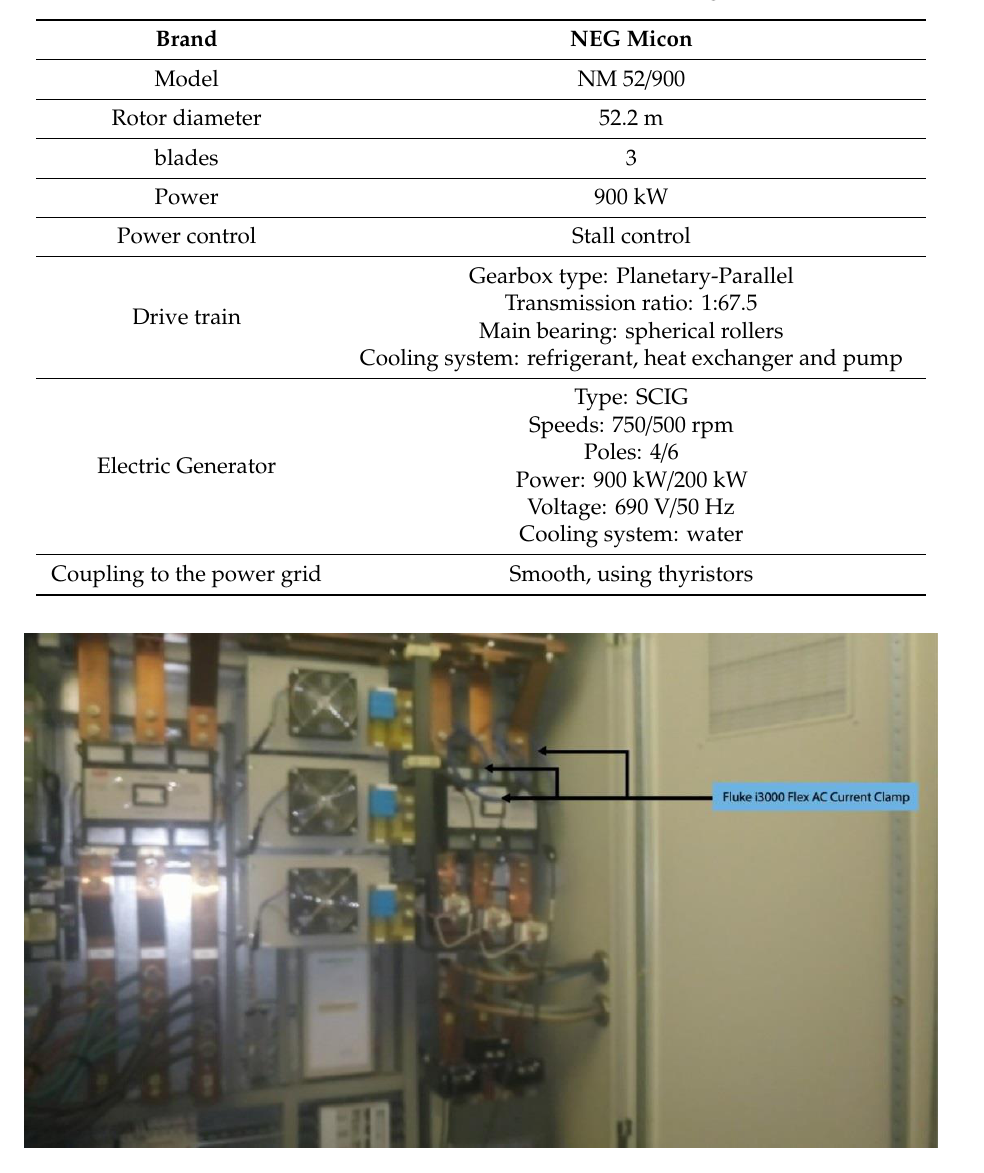
Table 1. Technical characteristics of the WT and electric generator.